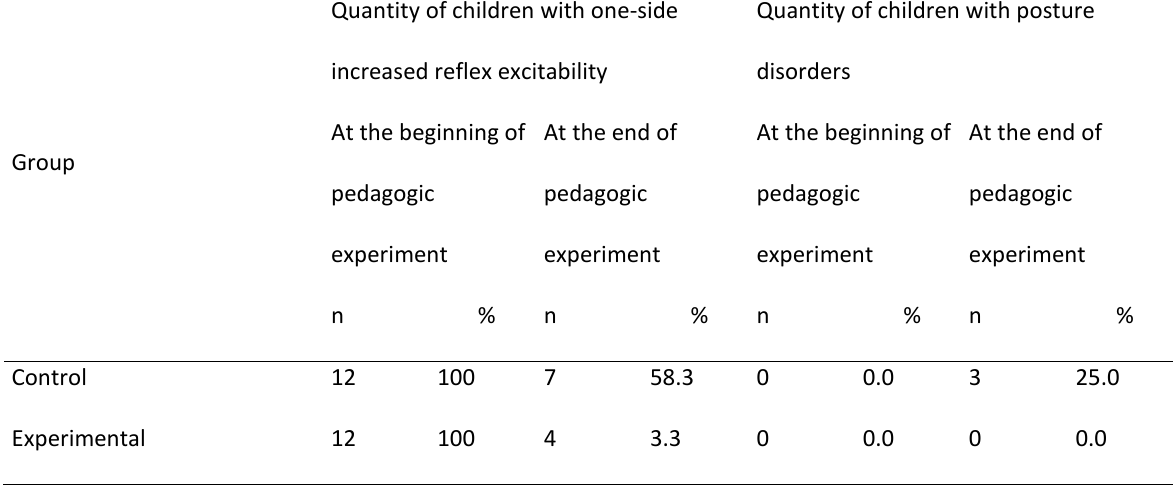
Table 2. Summarizing TVR of control and experimental groups’ children after